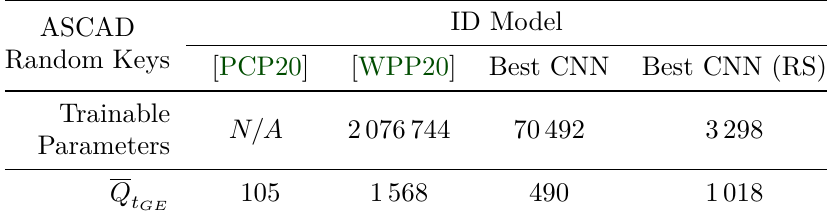
Figure 7: An overview of the number of trainable parameters, reward, the total search time, and the ε a neural network was first generated for the ASCAD with random key dataset experiments. Table 5: Comparison of the top generated CNNs for the ASCAD with random keys ID leakage model experiments with the current